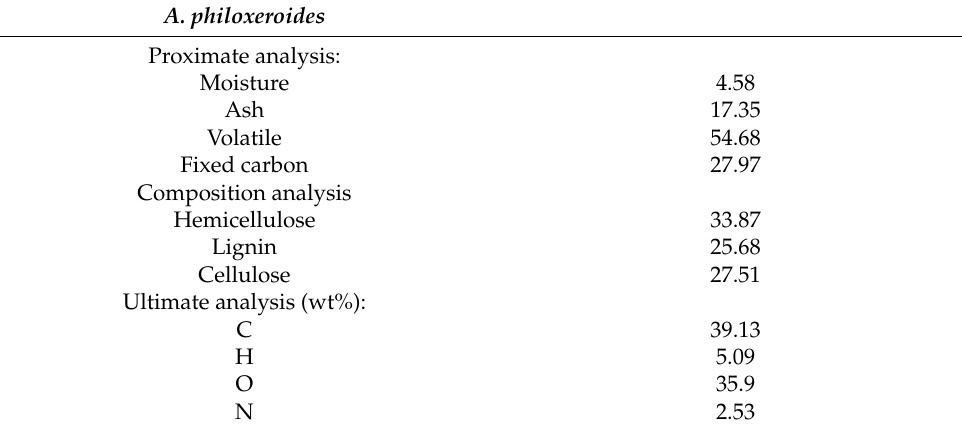
Table 1. Proximate and ultimate analysis of dried A. philoxeroides